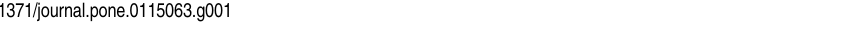
Fig. 1. Illustration of connections within a sample network based on participation of four countries (1 through 4) in two multinational clinical trials.